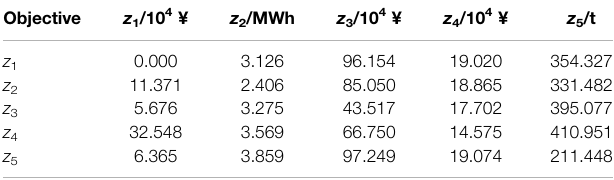
TABLE 3 | Objective function values of the SOP